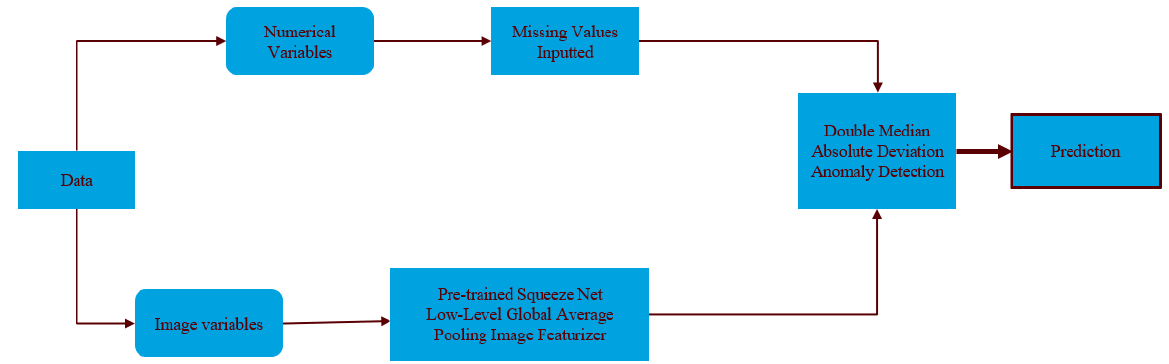
Figure 12. Unsupervised model workflow.